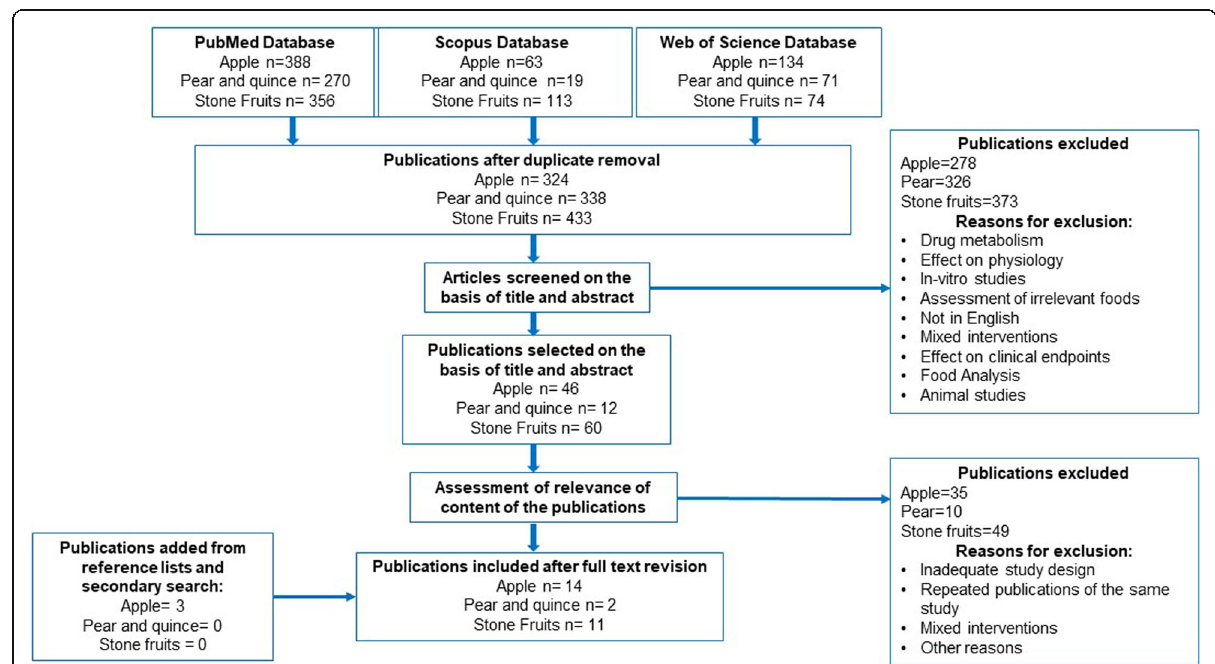
Fig. 1 Flow diagram of study selection according to the BFIRev